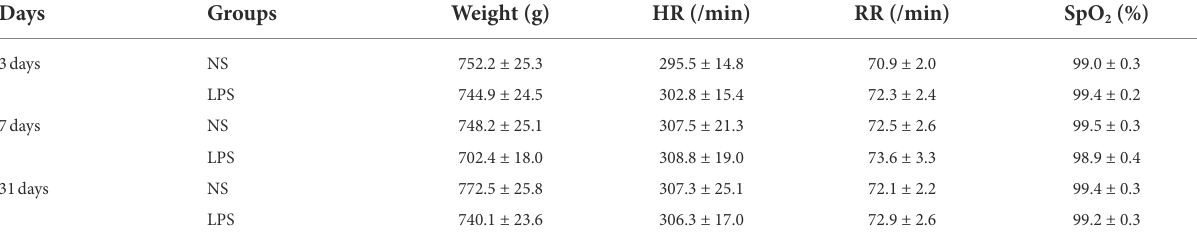
TABLE 3 Physiological factors during rs-fMRI data